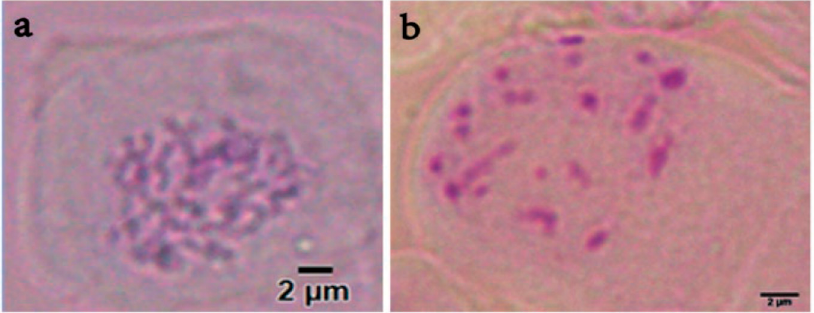
Figure 3. Chromosome counting of regenerated Liquidambar styraciflua × L. formosana plant ( a ) Chromosomes of a tetraploid plant. ( b ) Chromosomes of a diploid plant.